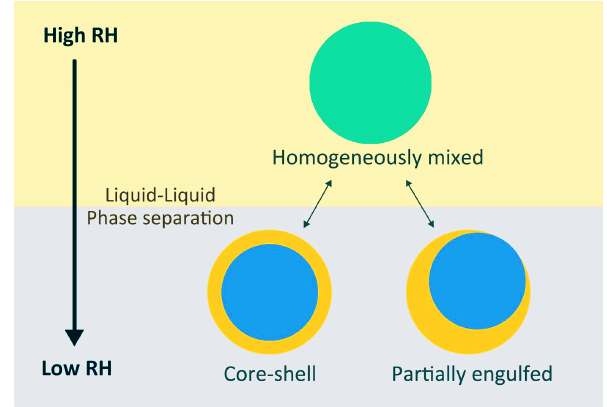
Figure 1. A simplified diagram for the phase separation in aqueous droplets containing inorganic salts, organic compounds and water. At high humidity, aqueous droplets exist as homogeneously mixed liquid. When the humidity decreases, they undergo phase separa- tion, leading to different morphologies such as core–shell and par- tially engulfed structures. Blue indicates the aqueous inorganic-rich phase; yellow indicates the organic-rich phase; bluish green repre- sents the homogeneously mixed single liquid phase